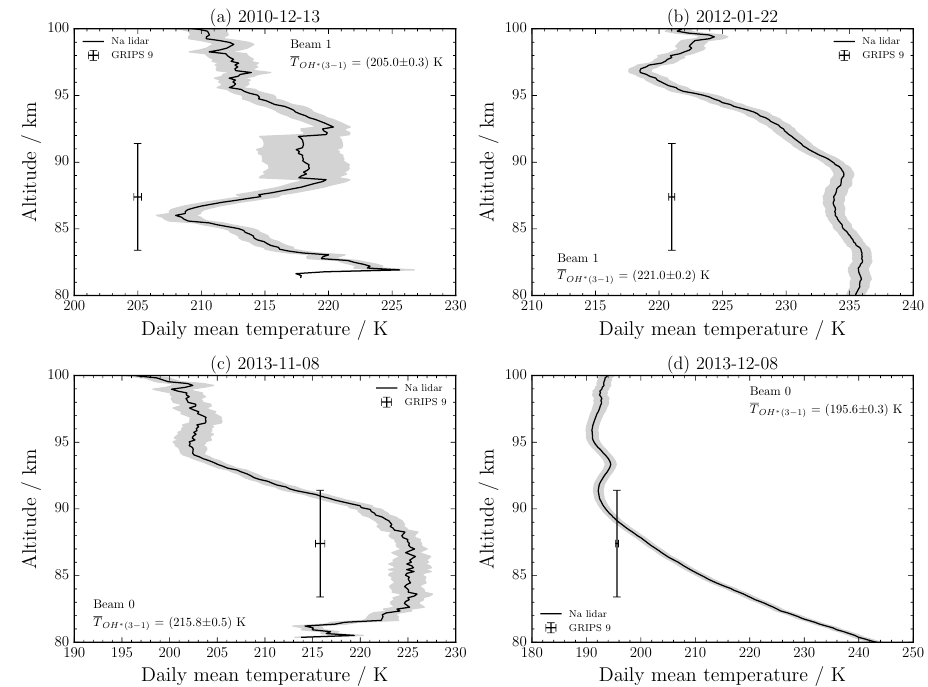
Figure 1. Nightly mean temperature profiles and standard error (grey shaded areas) measured by the Na lidar at ALOMAR. Also shown is the mean temperature and the standard error measured by GRIPS 9 during the same period of time. This temperature is plotted at an altitude of 87.4km and the vertical error bars are meant to indicate a hypothetical full width at half maximum of 8.4km. Date and common measurement duration: (a) 13 December 2010, 04:22h; (b) 22 January 2012, 13:46h; (c) 8 November 2013, 03:10h; (d) 8 December 2013,